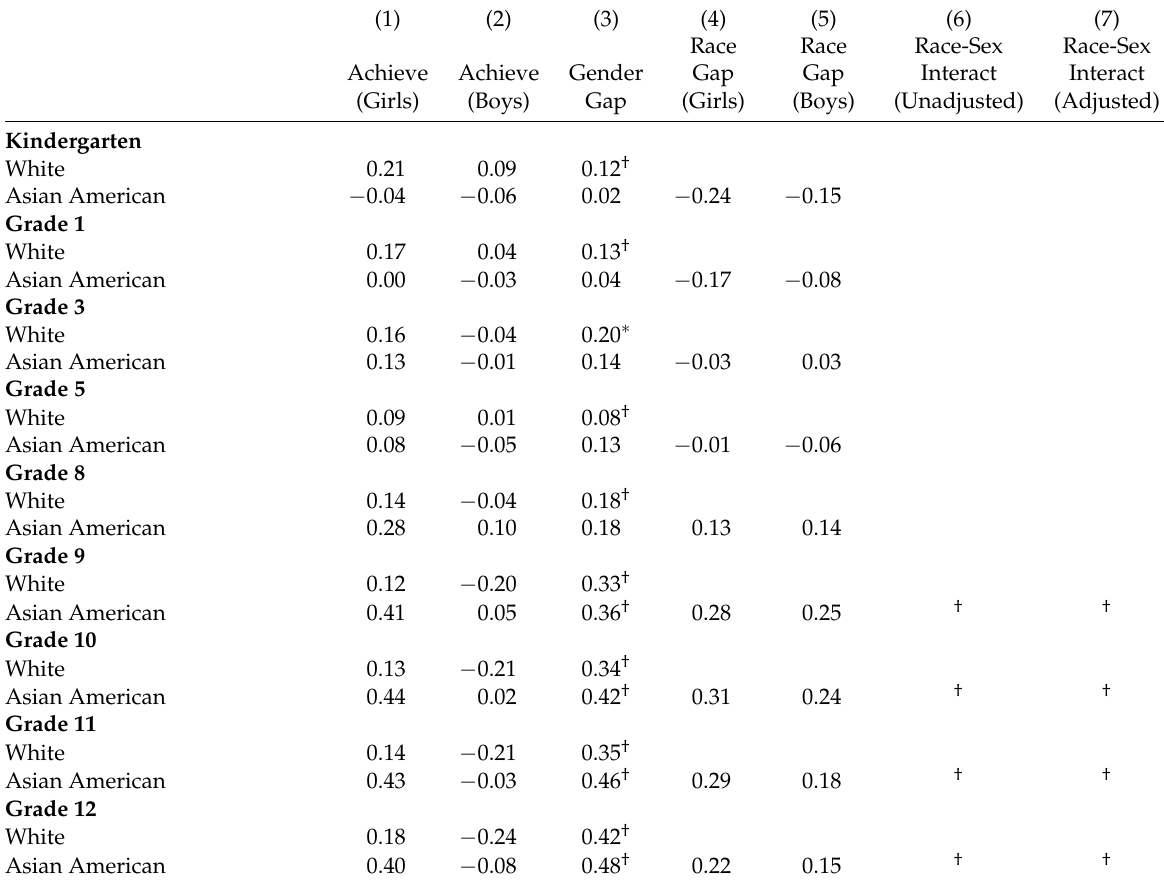
Table 3: Predicted achievement scores by race and gender.